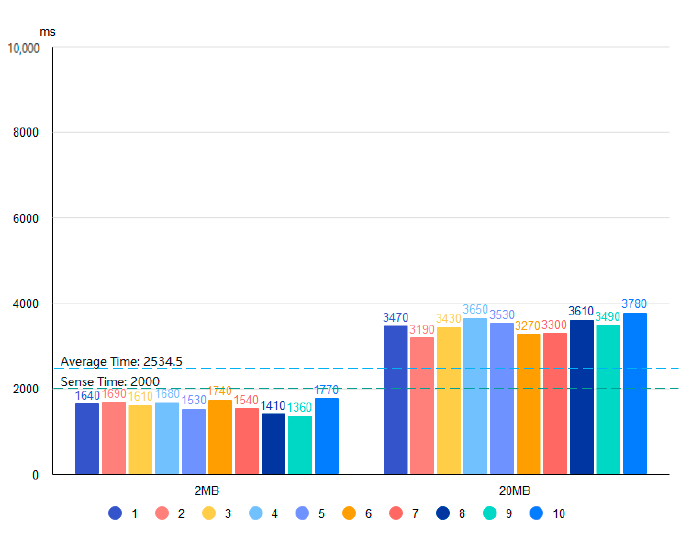
Figure 13. Time test of Pattern IV.